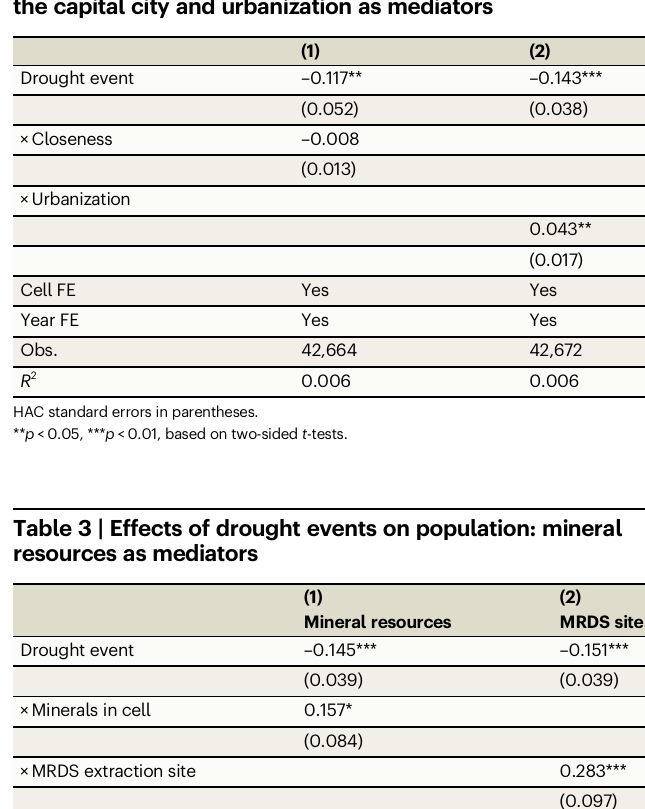
Table 2 | Effects of drought events on population: distance to the capital city and urbanization as mediators